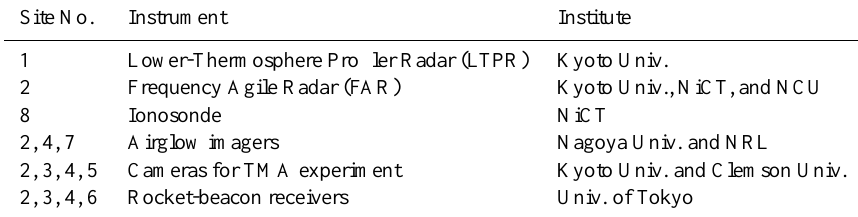
Table 1. Observation sites and ground-based instruments in SEEK-2. Site locations are shown in Fig. 2. Site No. Instrument Institute 1 Lower-Thermosphere Profiler Radar (LTPR) Kyoto Univ. 2 Frequency Agile Radar (FAR) Kyoto Univ., NiCT, and NCU 8 Ionosonde NiCT 2, 4, 7 Airglow imagers Nagoya Univ. and NRL 2, 3, 4, 5 Cameras for TMA experiment Kyoto Univ. and Clemson Univ. 2, 3, 4, 6 Rocket-beacon receivers Univ. of Tokyo